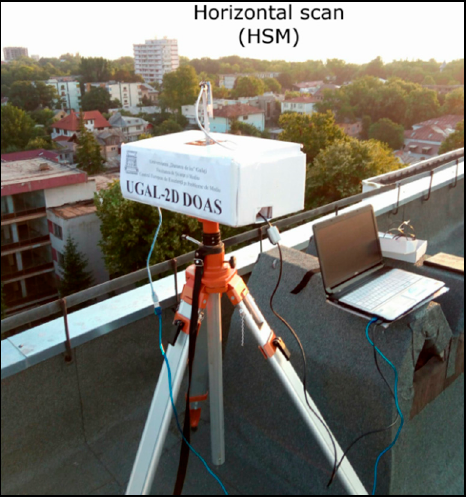
Figure 1. Image of the new University of Galati di ff erential optical absorption spectroscopy (UGAL-2D-DOAS) system performing